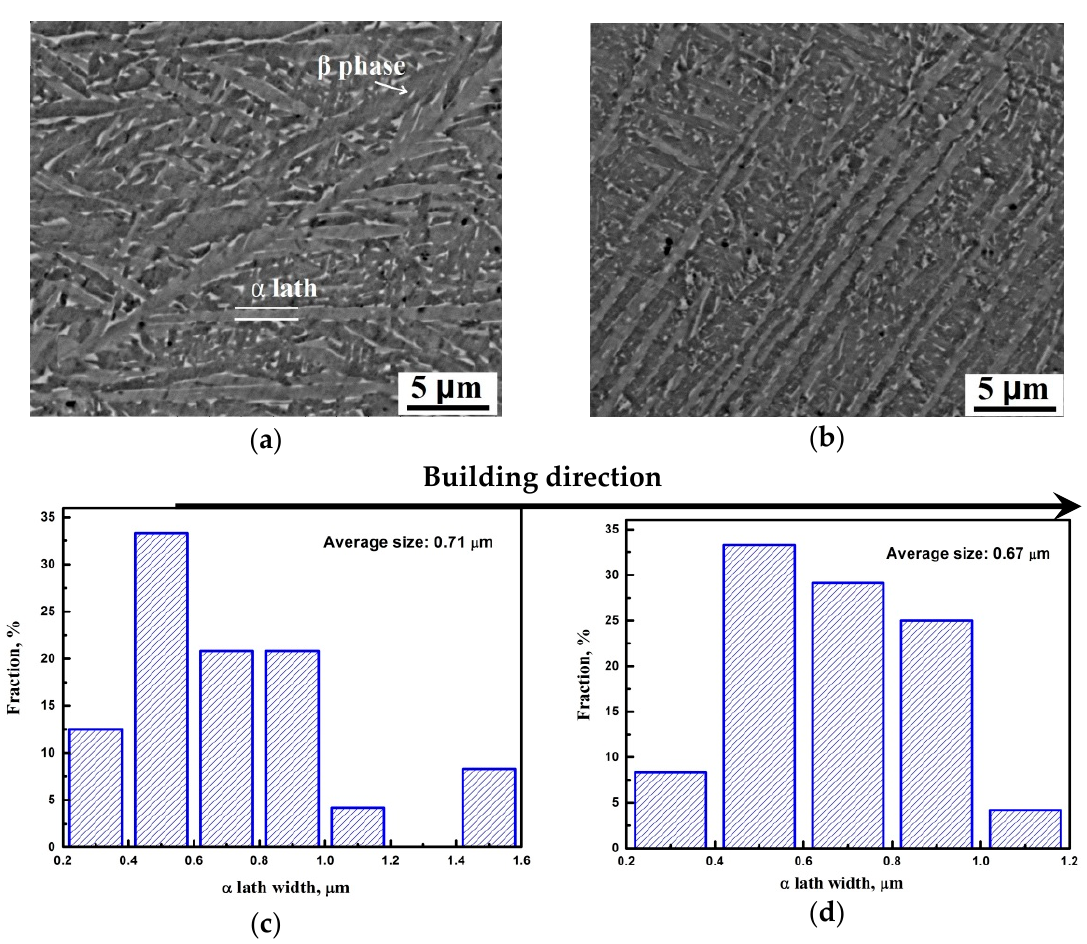
Figure 2. SEM images of the samples ( a , b ) and histogram ( c , d ) of the thickness distribution of α plates, respectively: ( a , c )—S1; ( b , d )—S2.